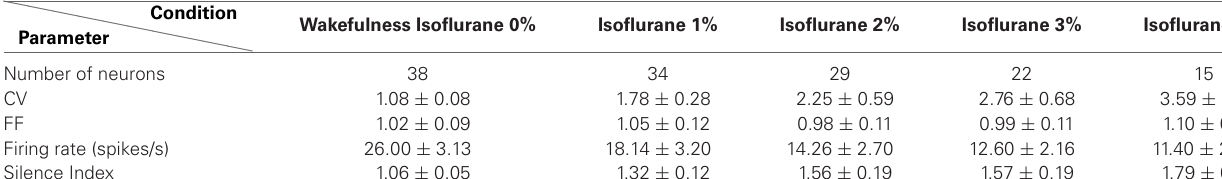
Table 1 | Firing parameters across conditions (mean ± sem).